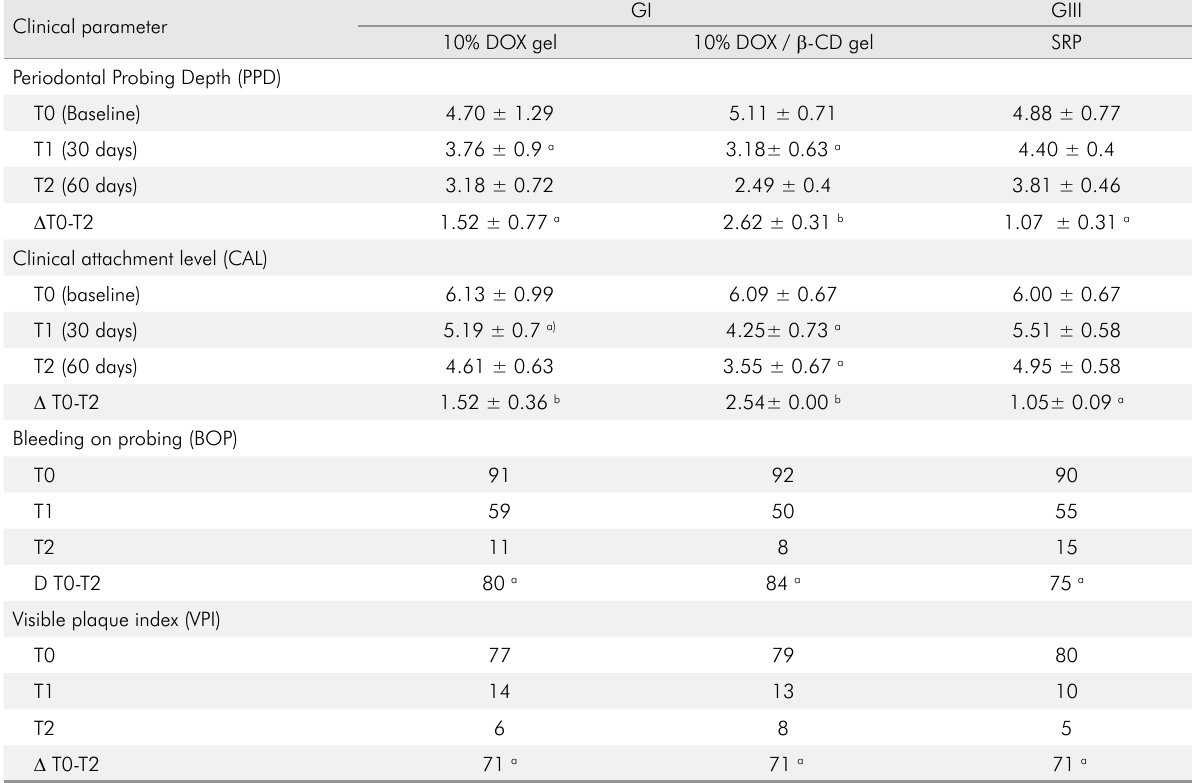
Table 2. Comparison of PPD within each group and among groups of 10% DOX gel and scaling and root planning (SRP) (GI), 10% DOX: β -cyclodextrin gel and SRP (GII) and SRP alone (GIII), at different time intervals: T0 (Baseline), T1 (30 days), T2 (60